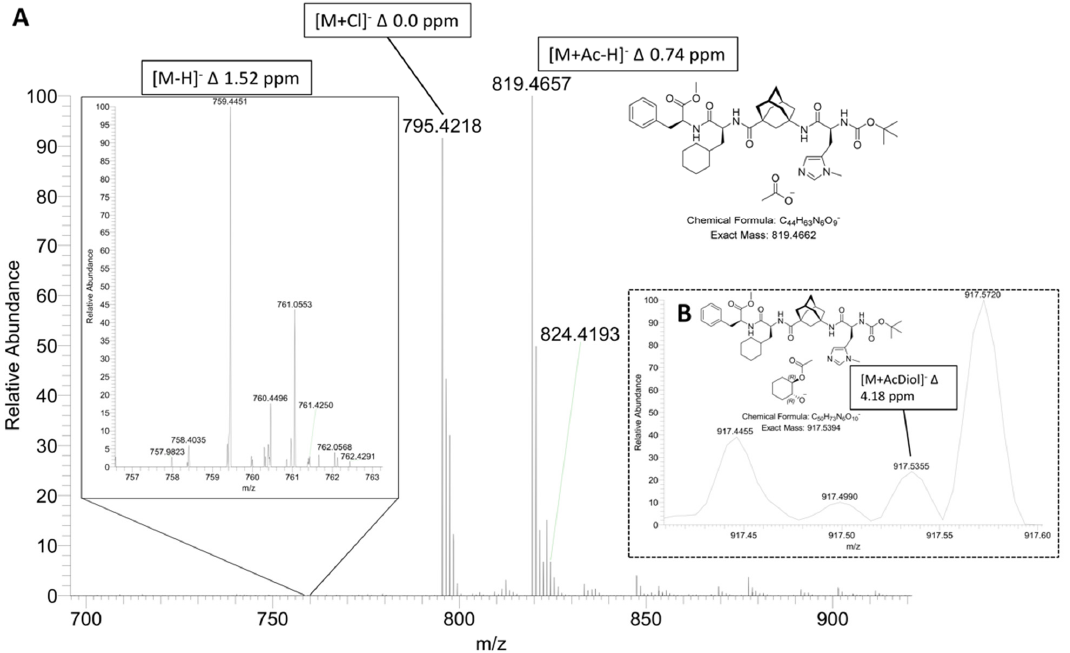
Figure 2. ( A ) Excerpt of full negative ion mode ( ESI − ) spectrum of tetrapeptide 1 with 1% acetic anhydride 4 and 1% acetic acid 15 sprayed from DCM. Insert of zoom on [M − H] − ion of tetrapeptide 1 ( m / z = 759.4451). ( B ) Selected Ion Monitoring (SIM) of m / z = 917.5 of tetrapeptide 1 with